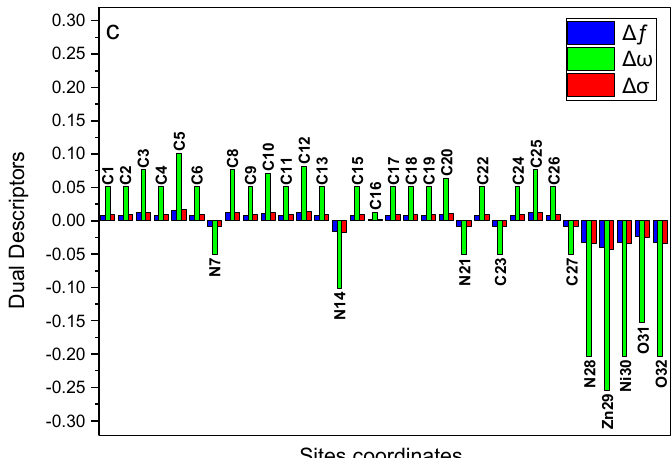
Figure 10. Graphical illustration of the Dual descriptors for the most efficient locations of the examined PANE, ZnO@PANE, and ZnNiO@PANE compounds.